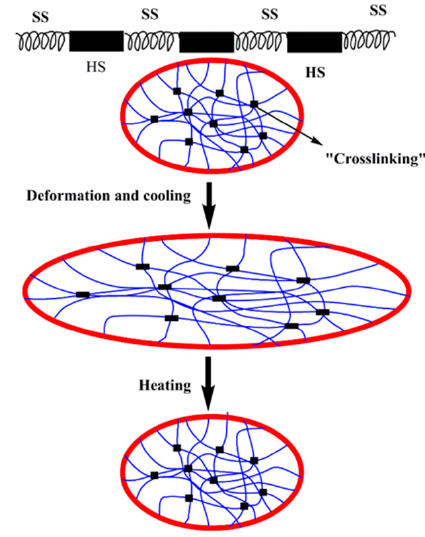
Figure 3. The micro-mechanism of the shape-memory effect of polymers, where HS refers to the hard segment, while SS refers to soft segments.